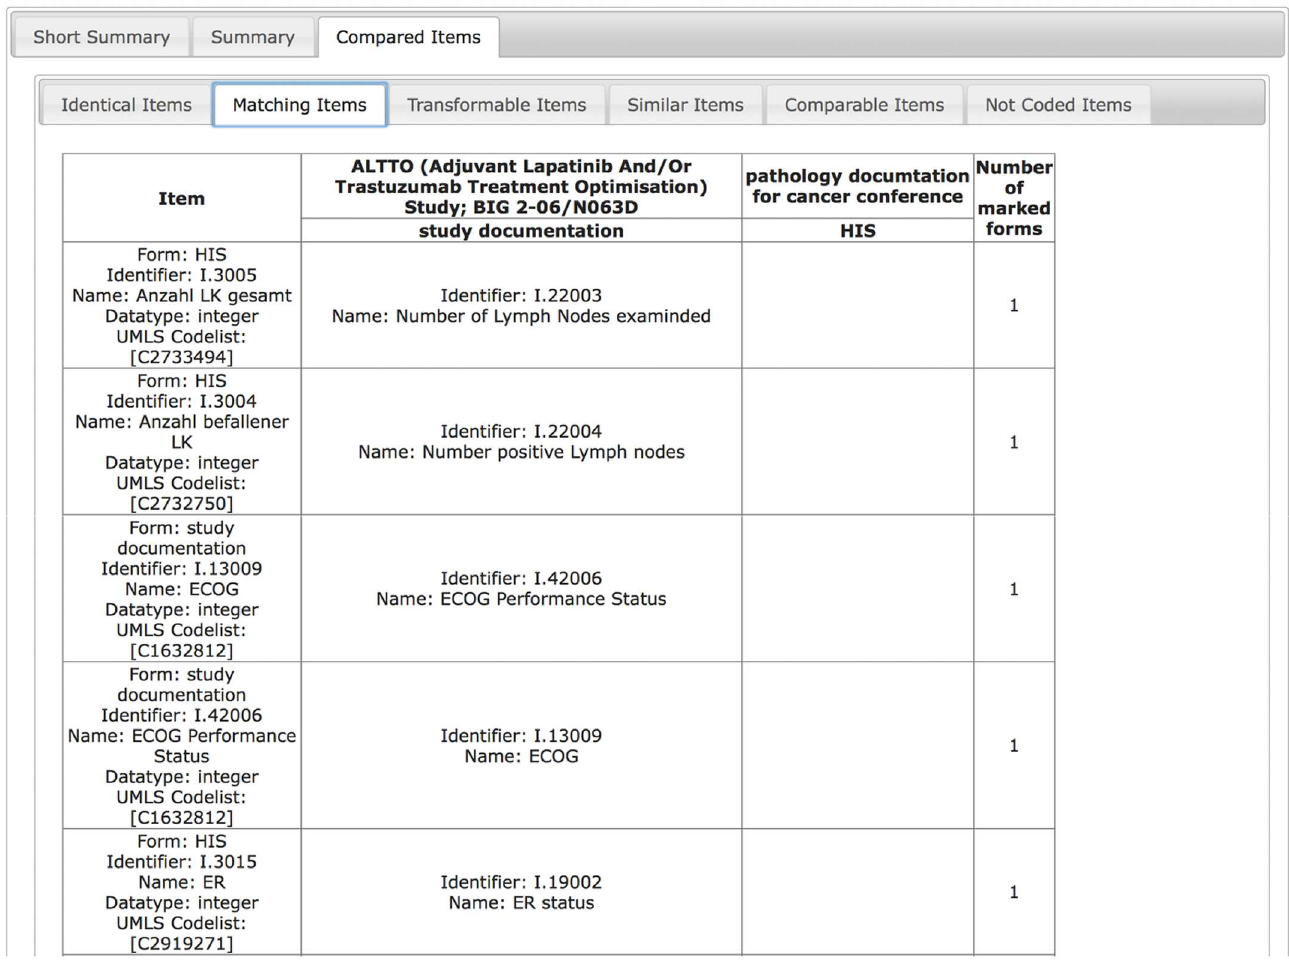
Fig 11. Concepts for „Number of Lymph Nodes examined“, „Number of positive Lymph nodes“, as well as ECOG Status and ER status are matching between clinical pathology documentation and trial